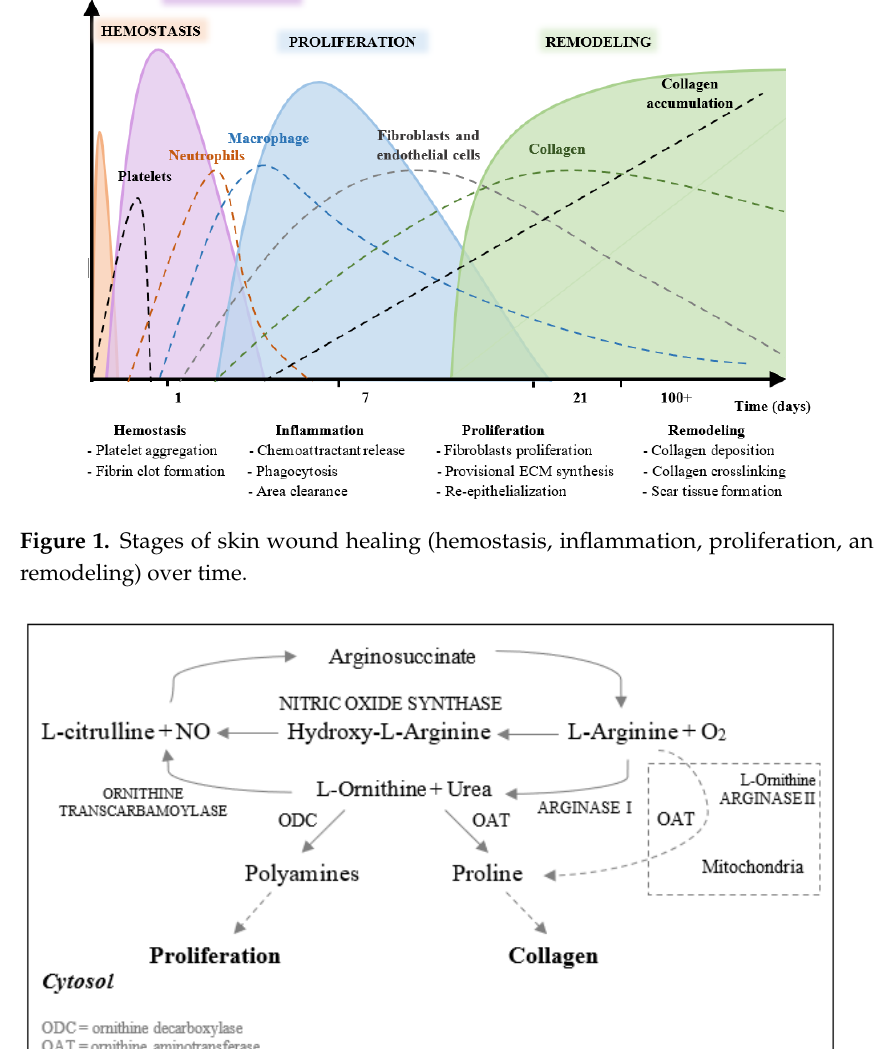
Figure 1. Stages of skin wound healing (hemostasis, inflammation, proliferation, and repair and remodeling) over time.